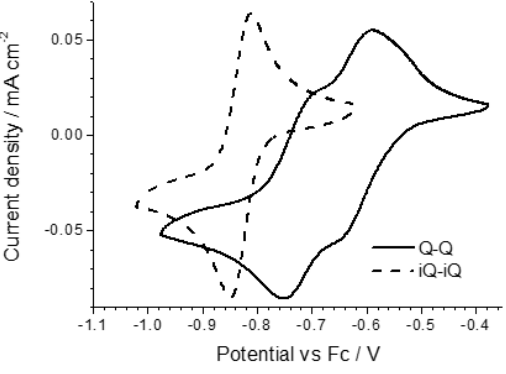
Figure 3. Cyclic voltammogram of the symmetric quinolinium (Q-Q)-based and isoquinolinium (iQ-iQ)-based ethenes.